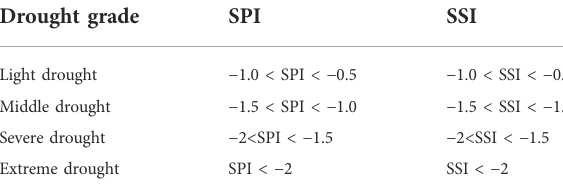
TABLE 1 Division of the different drought